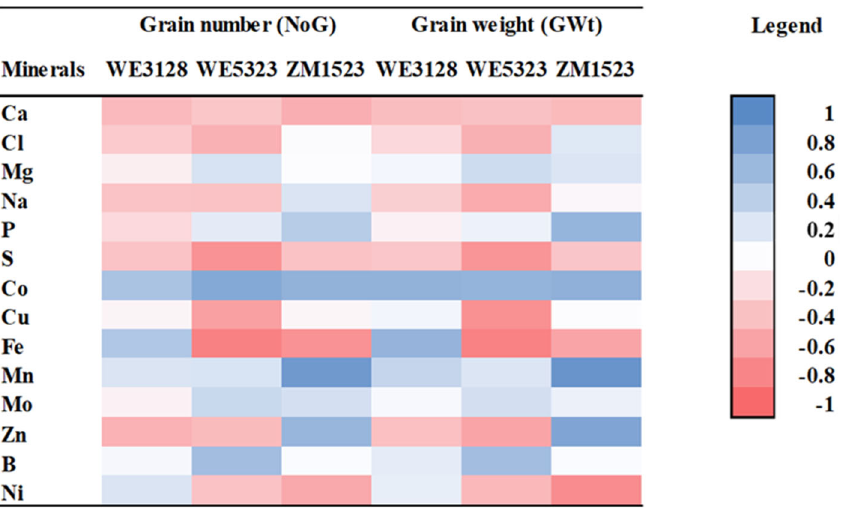
Figure 4. Grain mineral concentrations and grain yield correlation coefficient for maize varieties.